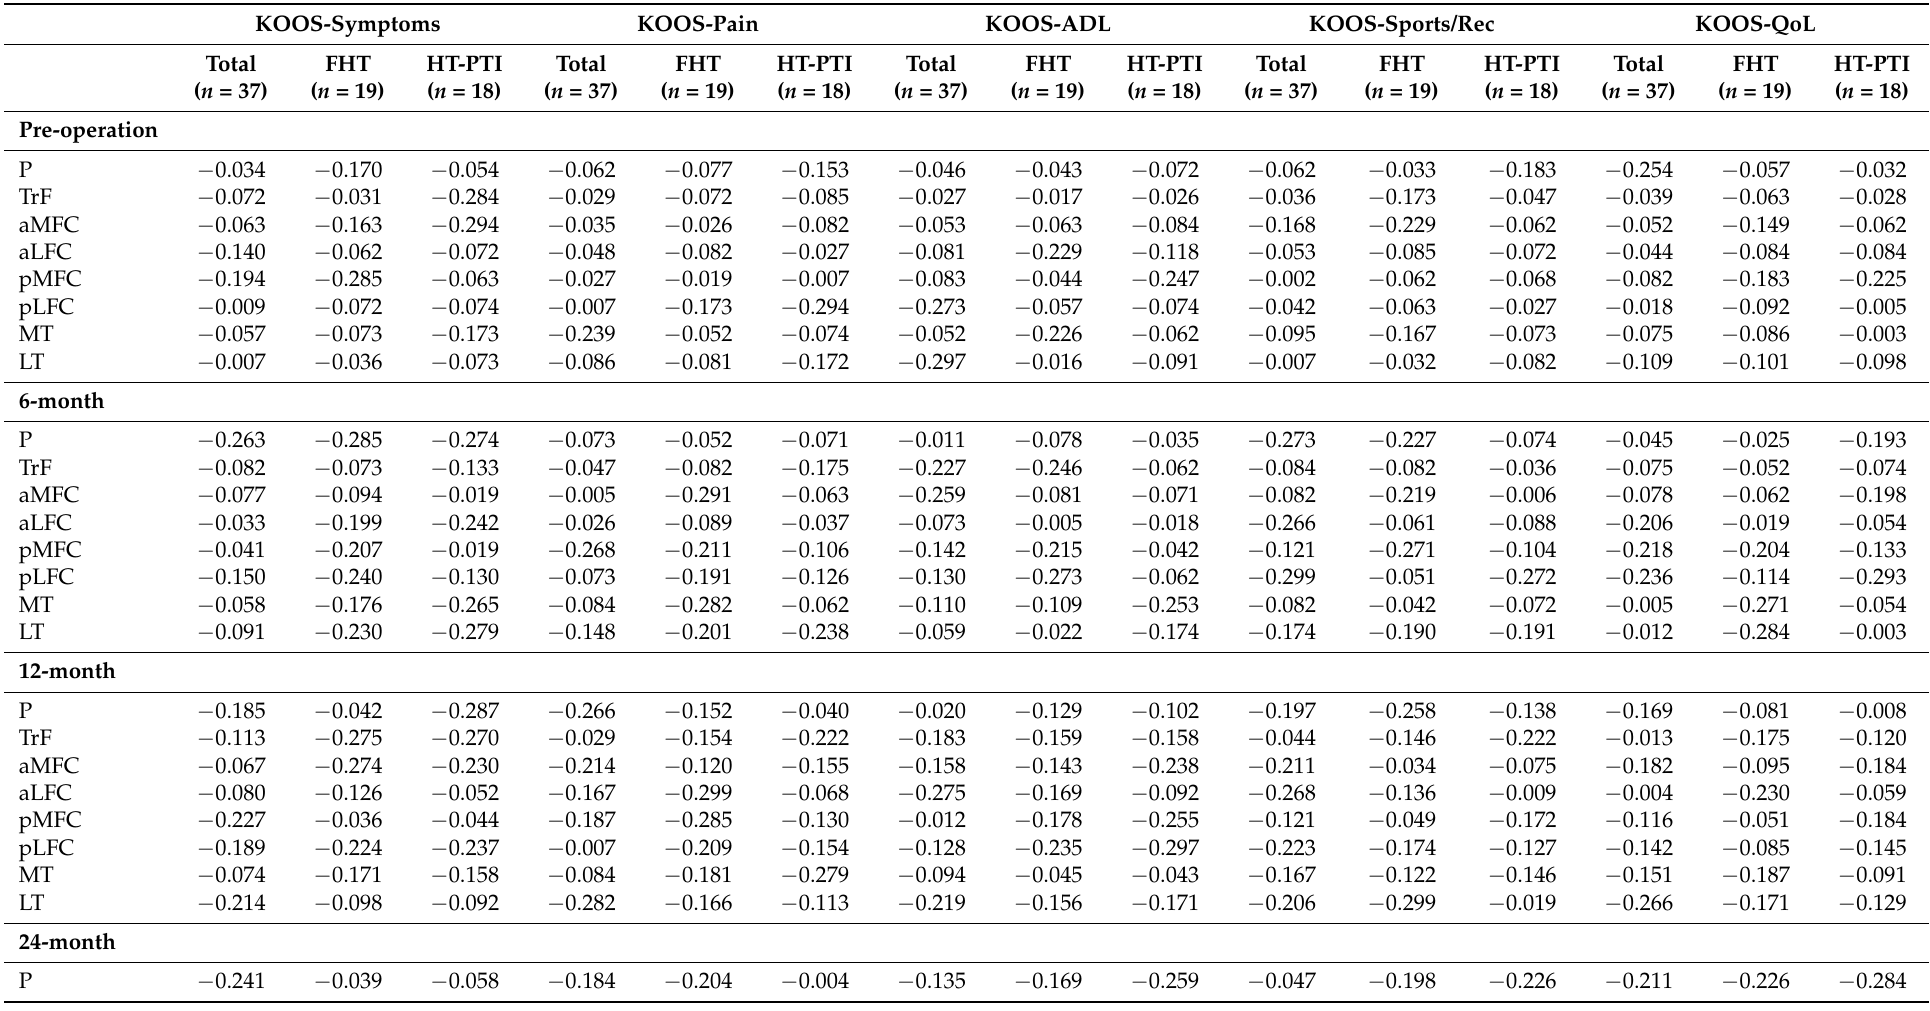
Table A1. Correlation between T2 value and KOOS of each cartilage sub-region before and after operation ( r value). KOOS-Symptoms KOOS-Pain